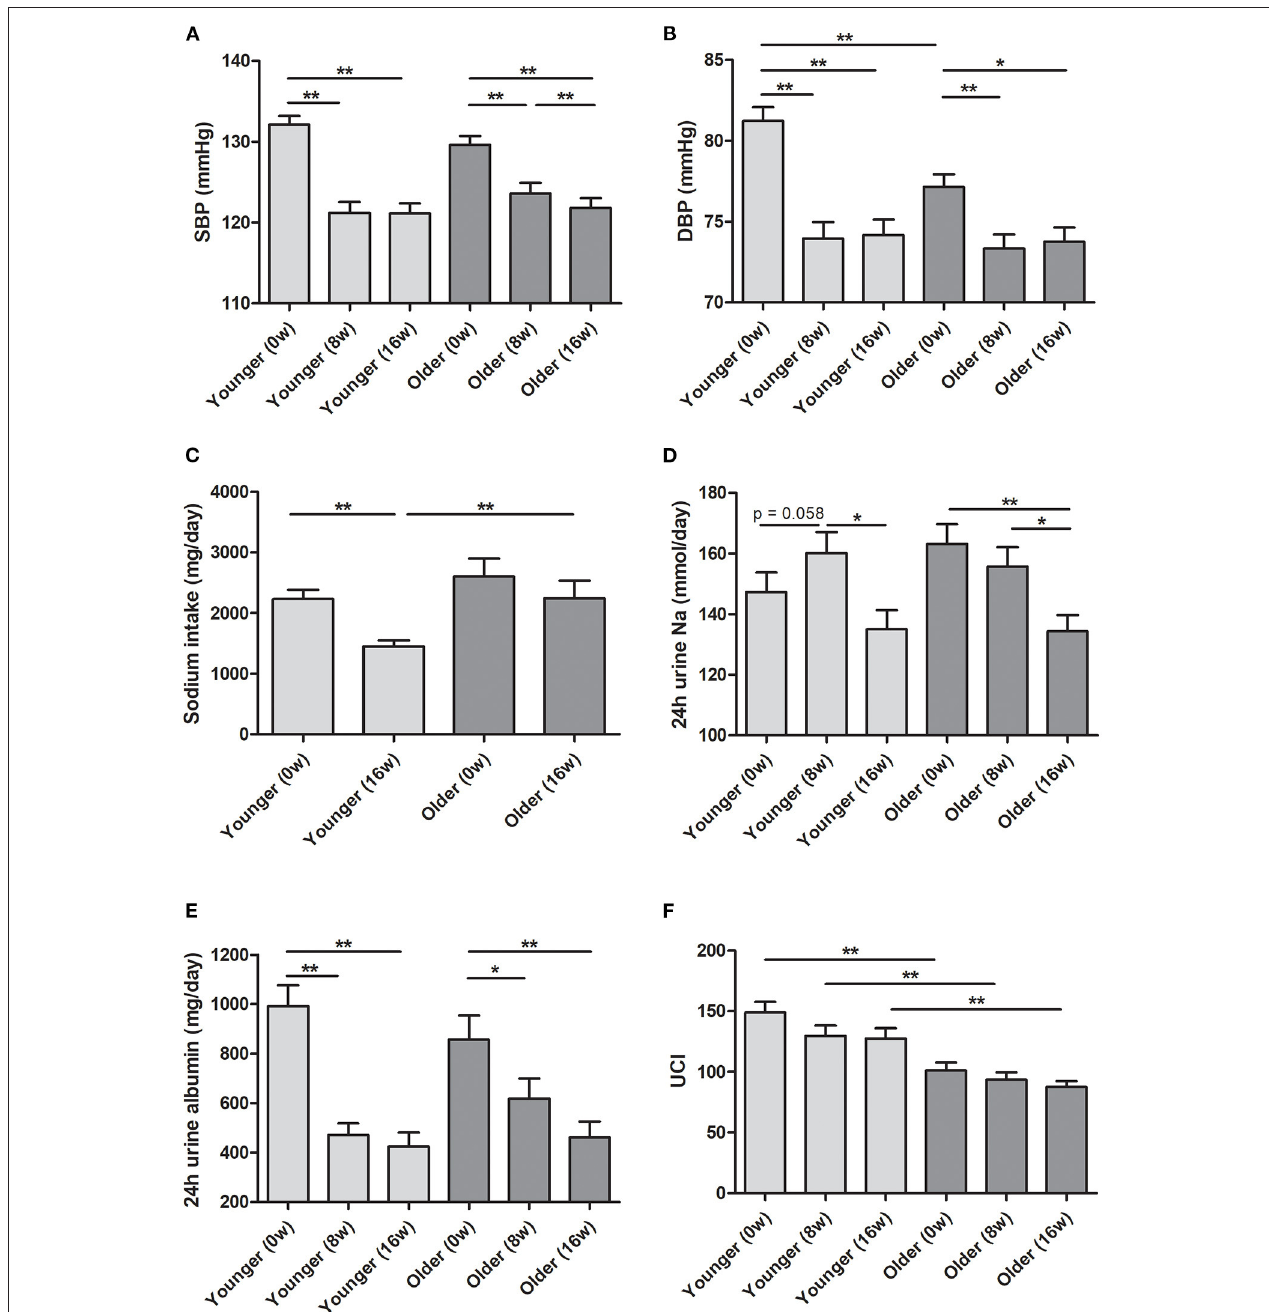
FIGURE 3 | Blood pressure and urine data in the ESPECIAL (Effects of Low Sodium Intake on the Antiproteinuric Efficacy of Olmesartan in Hypertensive Patients with Albuminuria) trial. (A) Systolic blood pressure (SBP). (B) Diastolic blood pressure (DBP). (C) Sodium intake (mg/day). (D) Estimated 24-h urine sodium (mmol/day). (E) Estimated 24-h urine albumin (mg/day). (F) Urine concentration index (UCI) in the younger and older groups at 0, 8, and 16 weeks (0, 8, and 16w, respectively). * p < 0.05 vs. different age group. ** p < 0.01 vs. different age